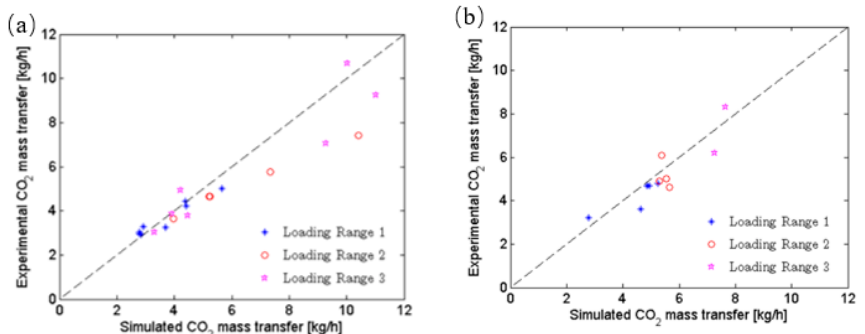
Figure 7. Comparison of experimental vs. simulation results ( a ) Validation of absorption process ( b ) Validation of desorption process.